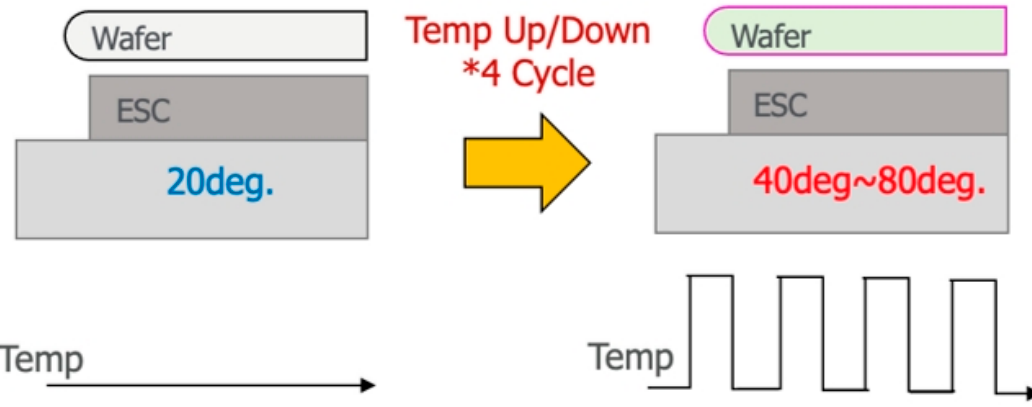
Figure 14. ESC heating cycle for the particle deposition test.